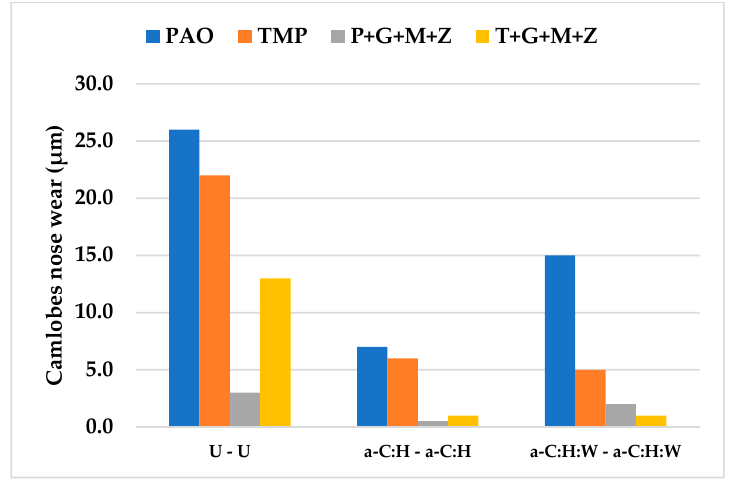
Figure 16. Nose wear of uncoated and DLC-coated camlobes under various conditions with PAO- based and TMP-based lubricants.